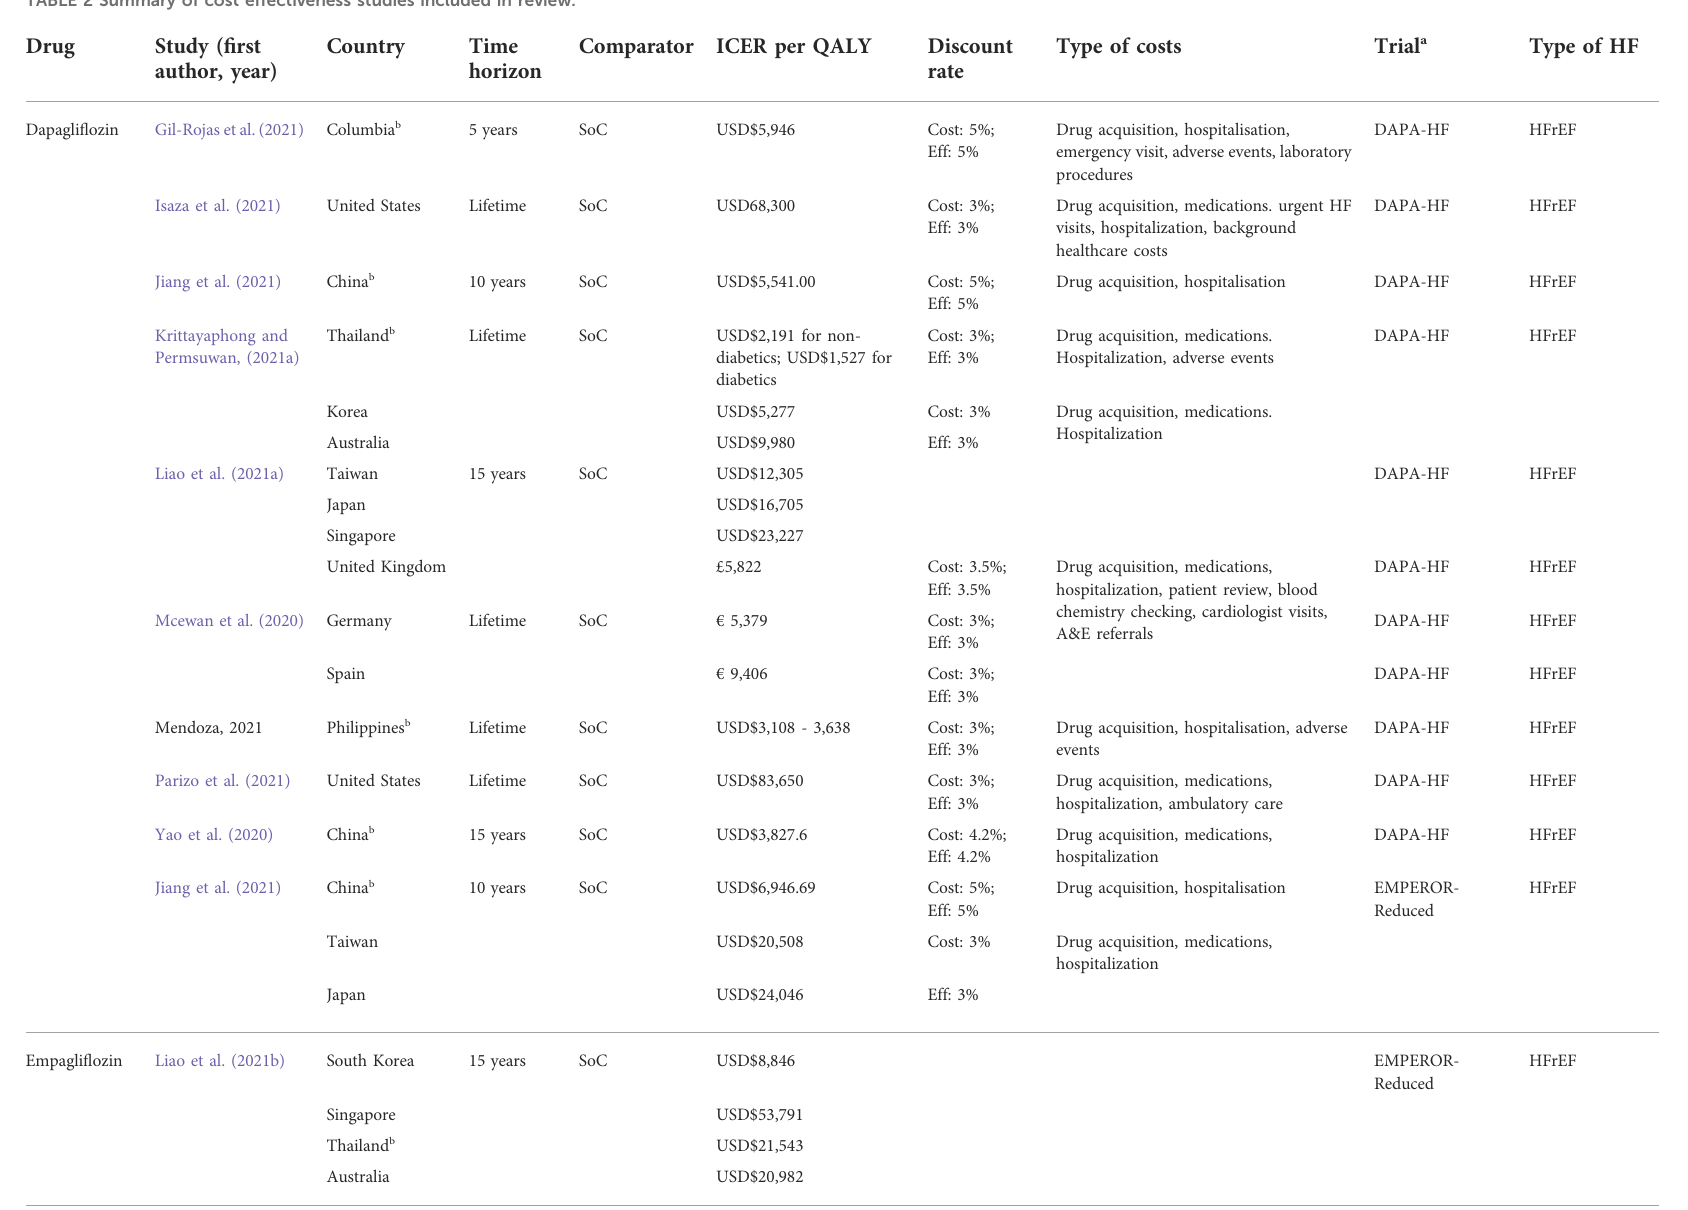
TABLE 2 Summary of cost effectiveness studies included in